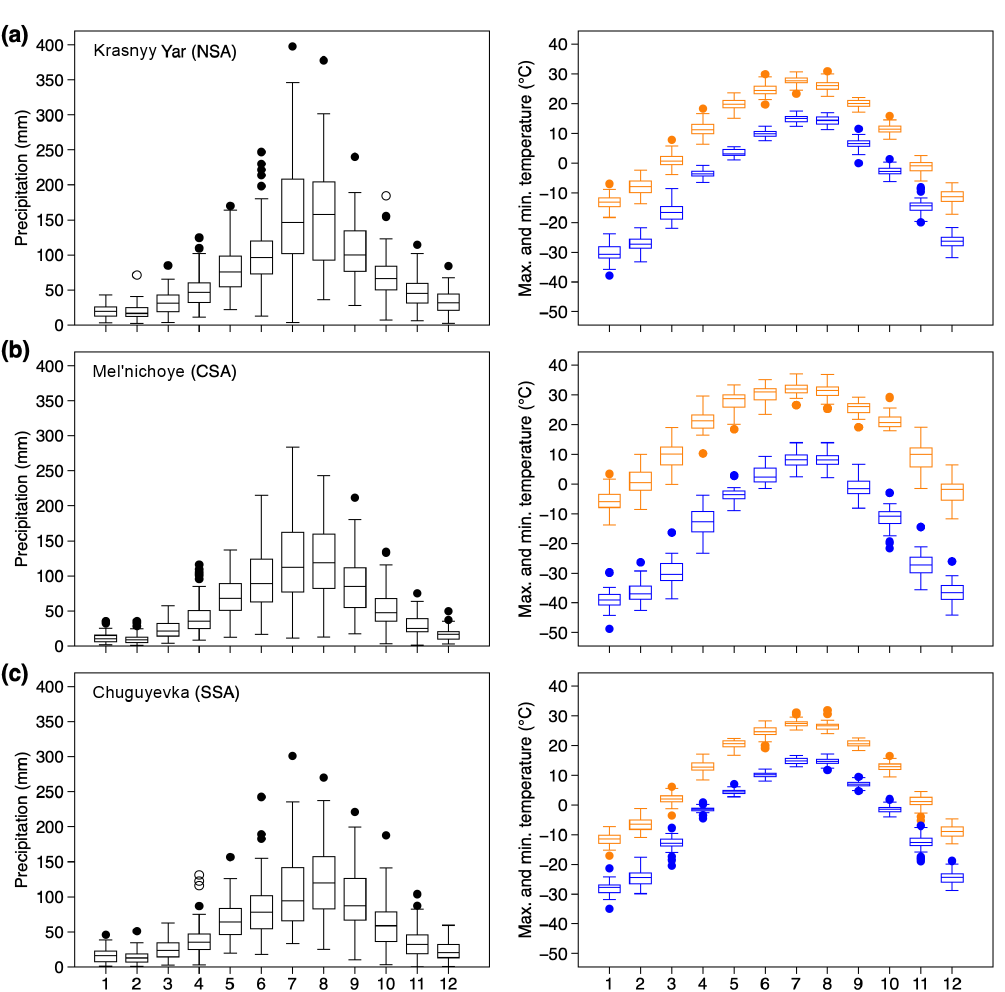
Figure 2. Monthly total precipitation, minimum and maximum temperature at (a) Krasnyy Yar (1940–2013), (b) Mel’nichoye (1941–2009) and (c) Chuguyevka (1936–2004) meteorological